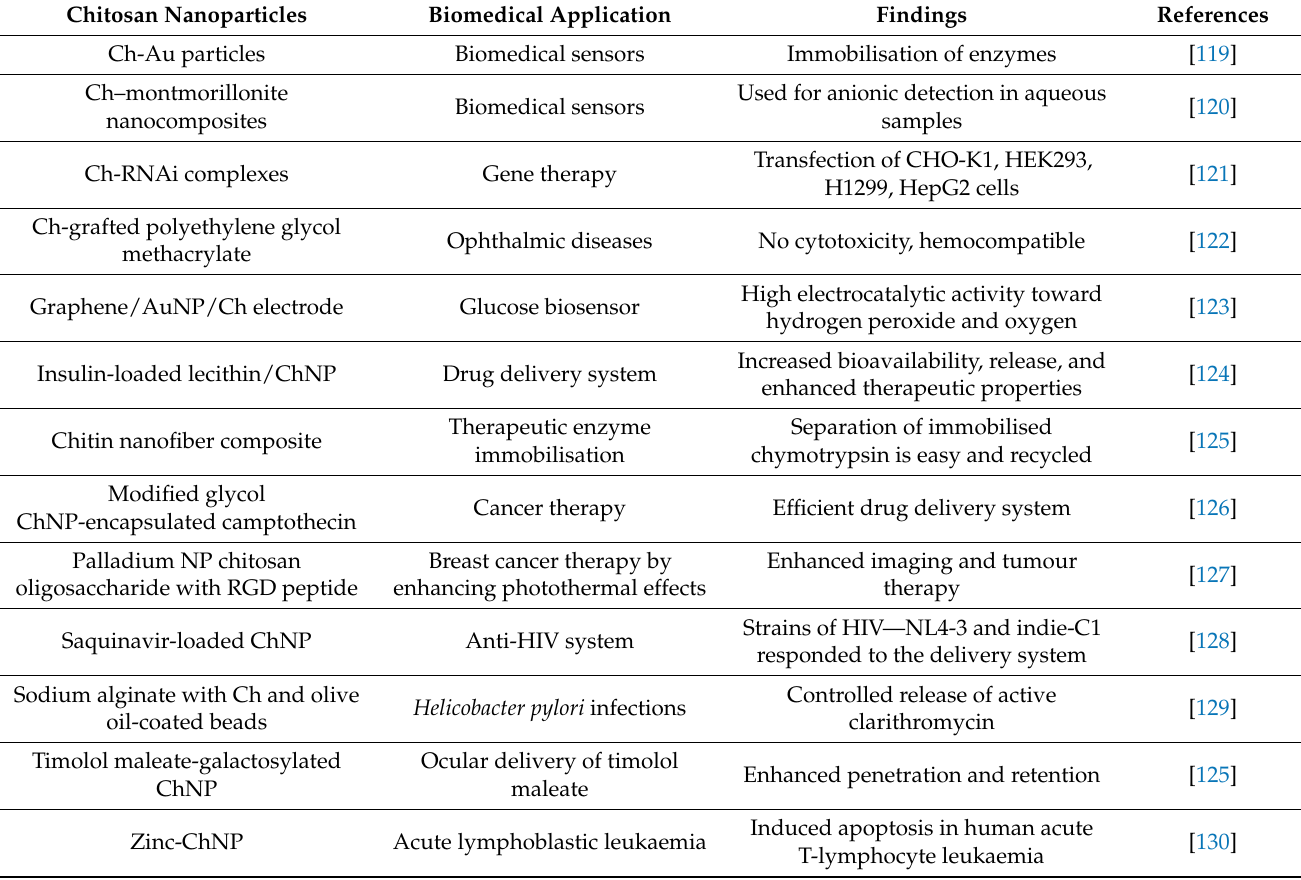
Table 1. Findings of chitosan-based nanoparticles used in biomedical